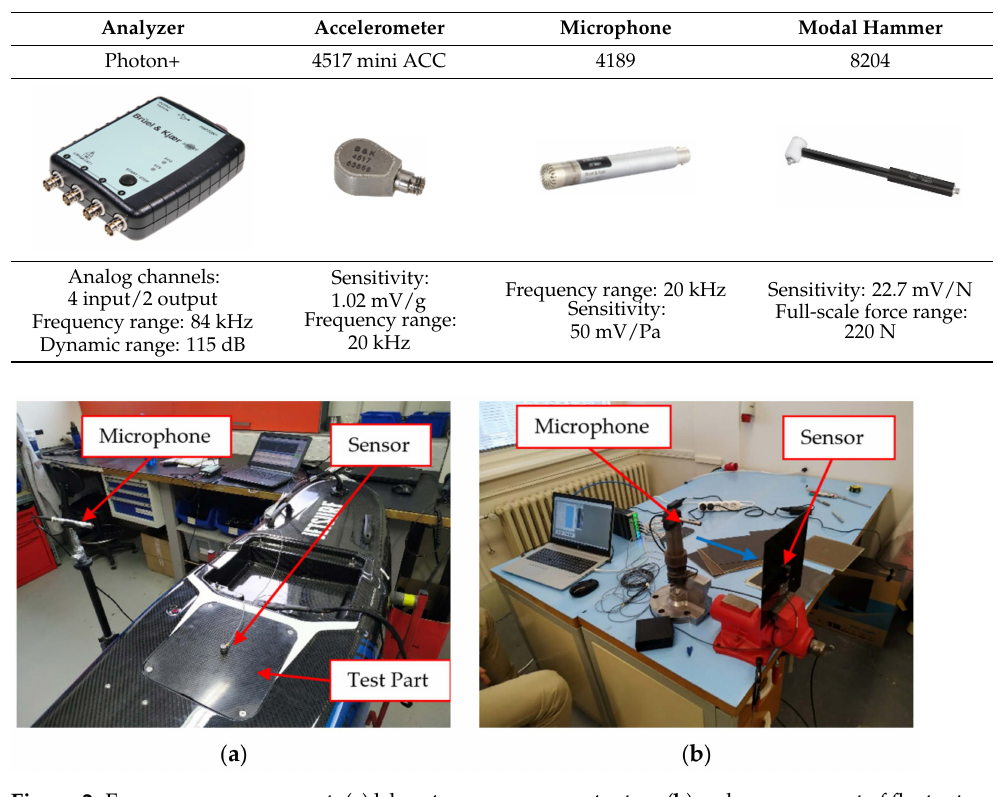
Figure 2. Frequency measurement: ( a ) laboratory measurement setup; ( b ) real measurement of float